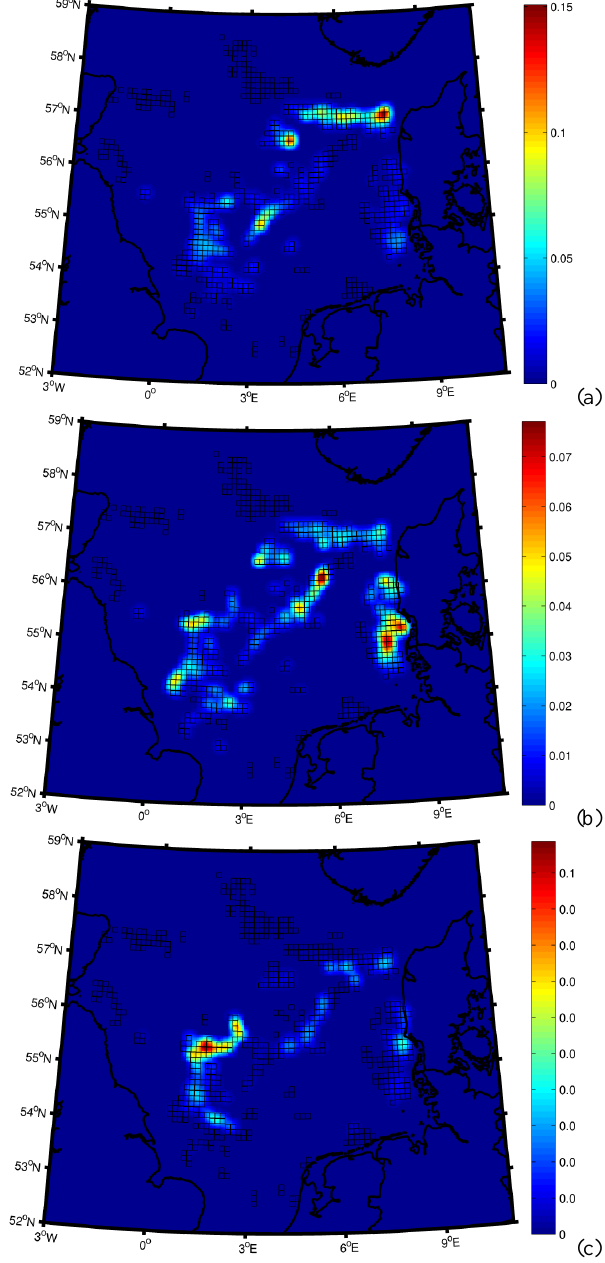
Fig. 7. Biomass distribution (in ktkm − 2 ) for contrasting years. (a) 1996, (b) 1997, and (c) 2004. Small transparent boxes show suitable habitat areas (as 10 × 10km boxes) for